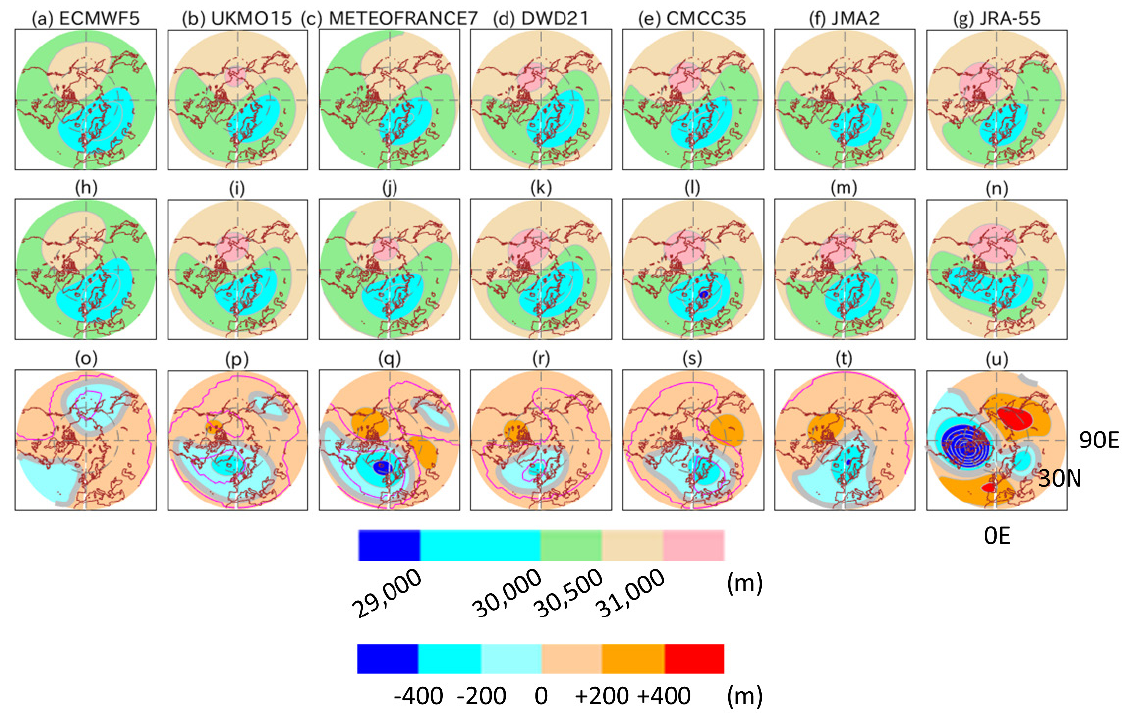
Figure 11. Similar to Figure 10, but for the 10 hPa GPH around the MSSW onset date of lag = ± 2 days. Panels ( a – n ) plot the 10 hPa GPH, and ( o – u ) plot its differences. All wave components in addition to the zonal mean are retained.